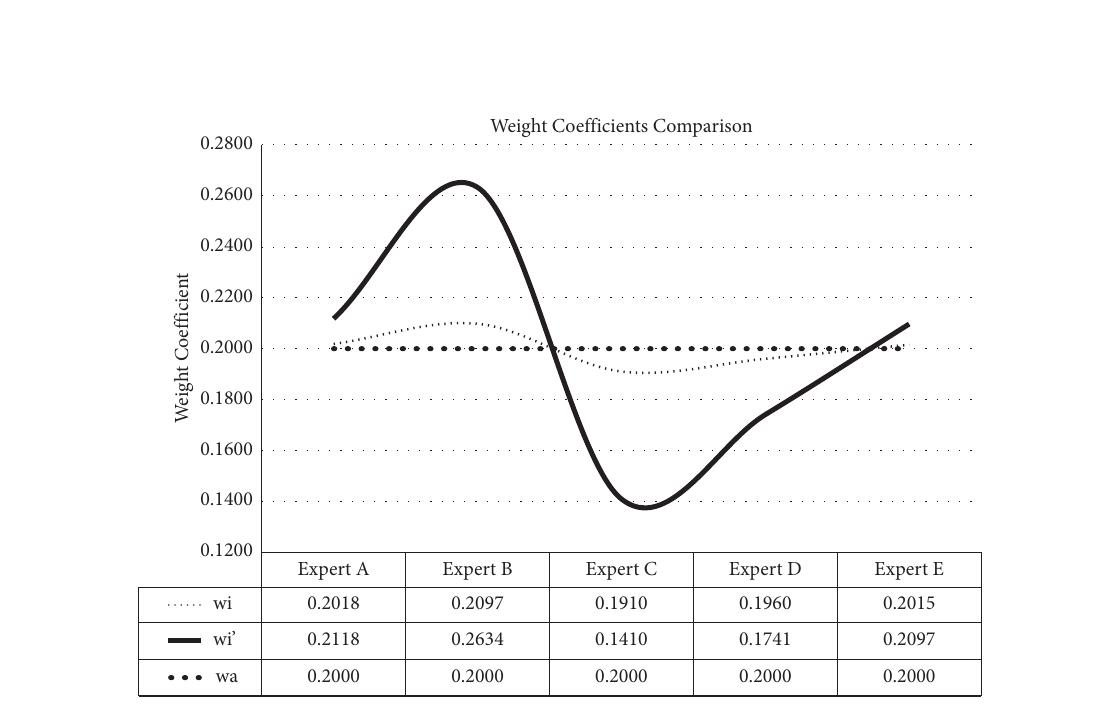
Figure 4: The expert weight coefficients comparison.